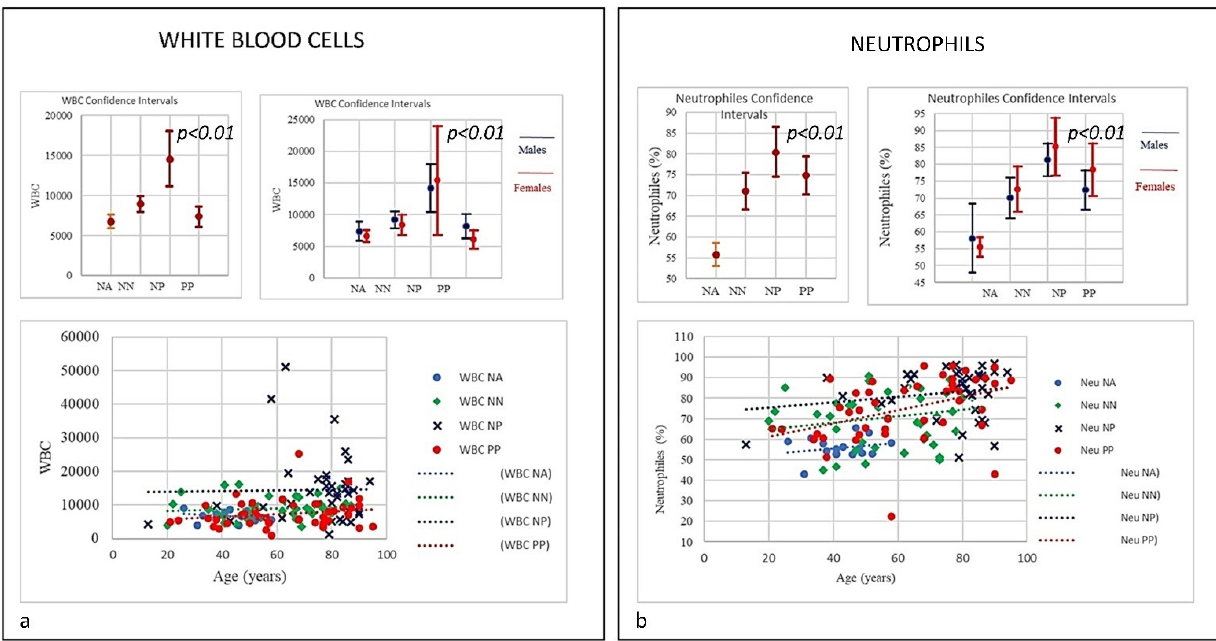
Figure 1. ( a ) Frequencies of white blood cells (WBC). The differences in WBC count and neutrophils between PP patients and controls NP, NN, and NA (age and sex) were statistically significant ( p = 0.01), the trend indicated that PP patients showed the lowest level of WBC, very close to NN group compared to NP group. ( b ) Neutrophils in COVID-19 patients and controls (NP, NN and NA). The neutrophils trend in PP, NP, and NN groups was increasing with age. Both PP and NA started from a lower range compared to NP. PP and NP shared the highest level with age.